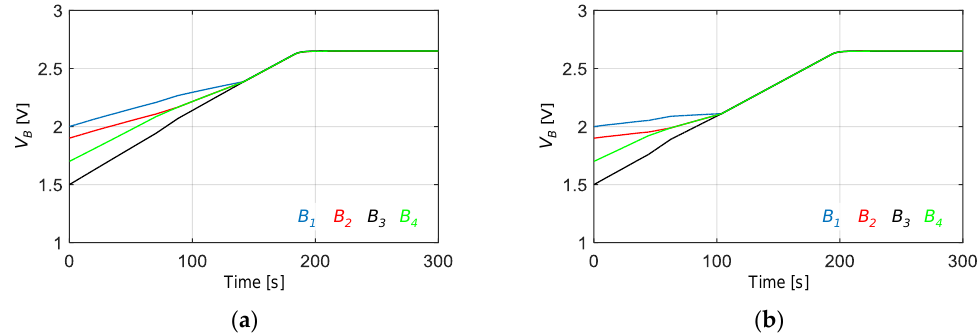
Figure 10. EDLC cell voltage, charged by the constant current-constant voltage (CC-CV) charger with the string-to-cell balancer altered from the SIMO SC converter; ( a ) with a 0.32 duty cycle for Q 1 ; and ( b ) with a 0.35 duty cycle for Q 1 .